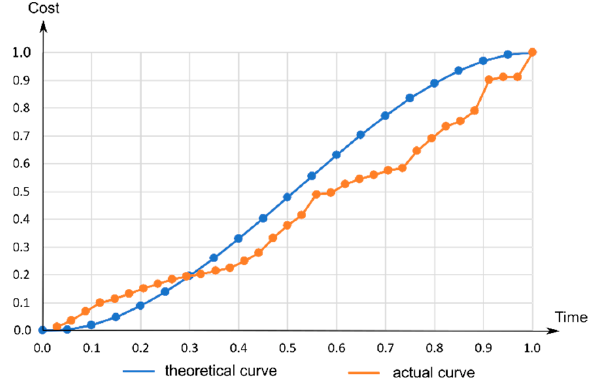
Figure 3. Graph of theoretical and actual cost curve.